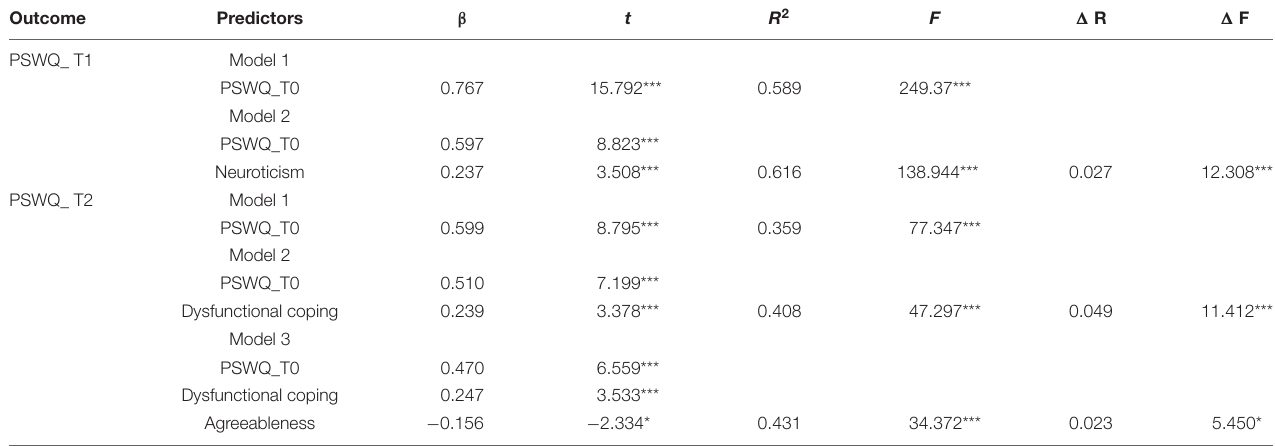
TABLE 4 | Stepwise regression analysis on worry during COVID-19 with personality traits and coping strategies as predictors.